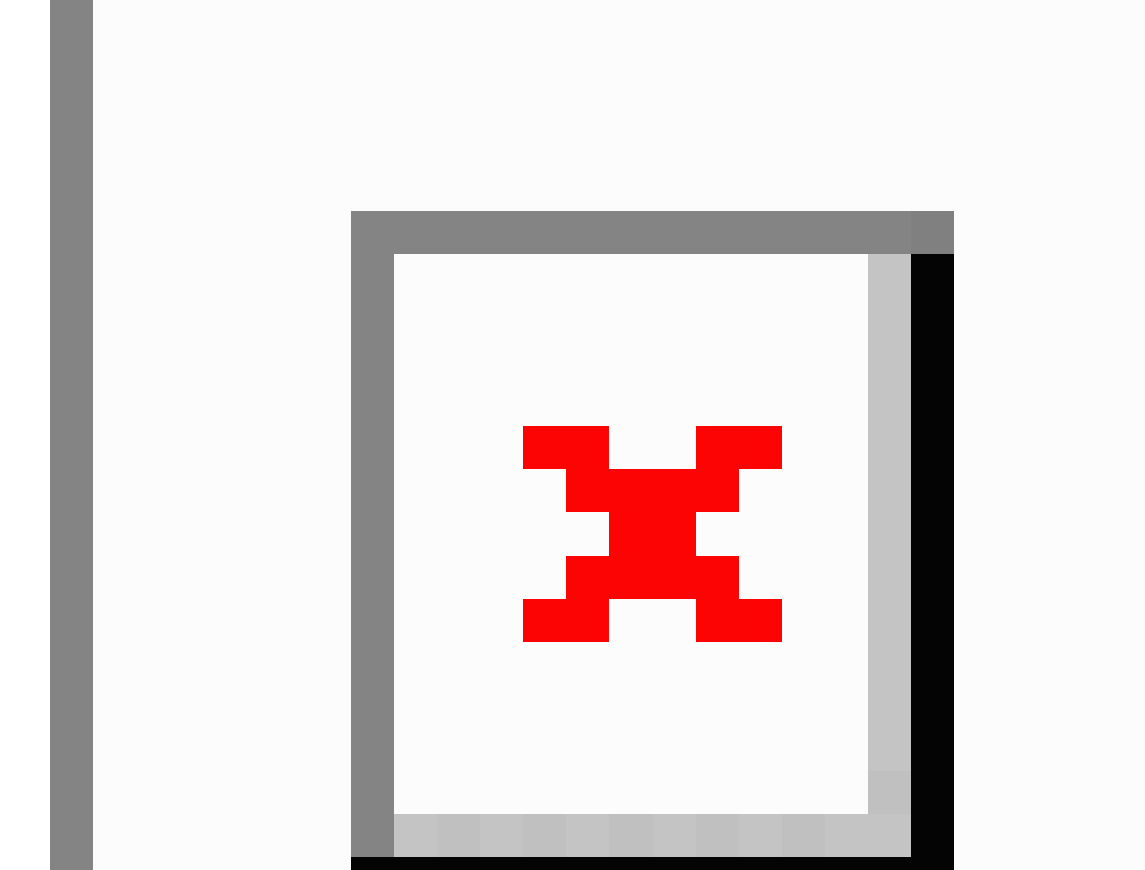
Figure 1. Overview of inclusion procedure